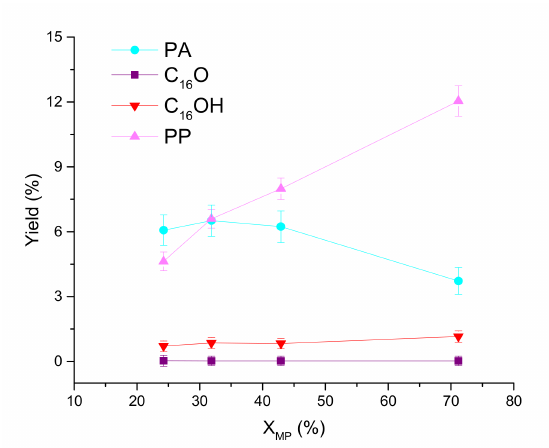
Figure 8. Yields of oxygenated intermediates vs. X MP over Ni 2 P/SiO 2 – γ -Al 2 O 3 system Reaction conditions: P H —3.0 MPa, H 2 /feed—600 Nm 3 /m 3 , T —270 ◦ C, WHSV—5 h − 1 . PA—palmitic acid 2 (C 15 H 31 COOH), C 16 O—hexadecanal (C 15 H 31 CHO), C 16 OH—hexadecanols (C 16 H 33 OH), PP—palmityl